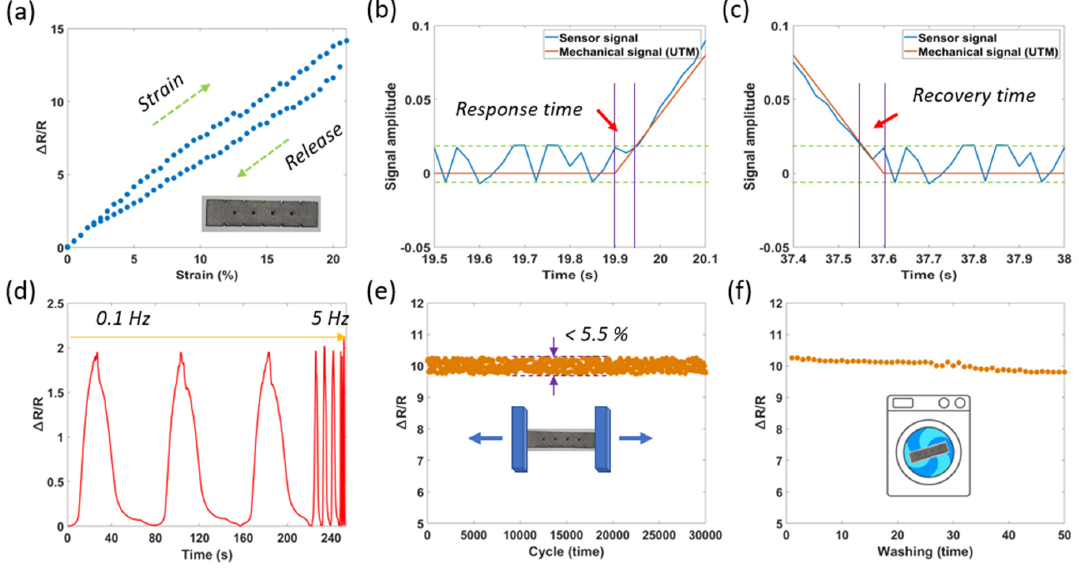
Figure 7. Characteristics of the Ag/SWCNT sensors (integrated small BCLs) consisting of ( a ) hysteresis, ( b ) response time, ( c ) recovery time, ( d ) signals at different frequencies, ( e ) durability after 30,000 stretching/releasing cycles, and ( f ) durability after 50 washing times.